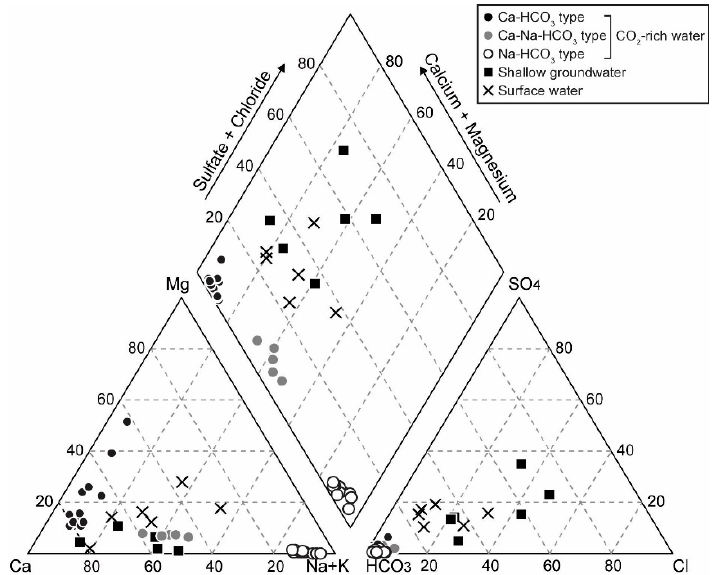
Figure 3. Piper diagram showing the hydrochemical compositions of water samples in the study area. CO 2 − rich water in the Gangwon area is clearly grouped into three water types, Na–HCO 3